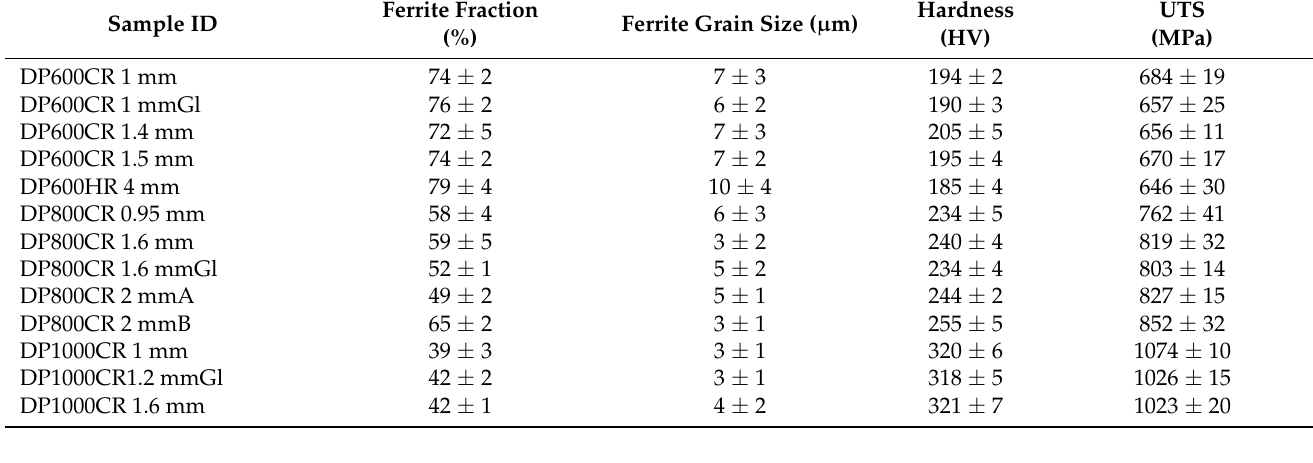
Figure 1. SEM micrograph of commercial DP600, DP800 and DP1000 steel samples (in InLens mode with 5 kV). Table 1. Summary of the ferrite fraction, hardness and grain size of commercial DP steels, HR = Hot-rolled, CR = Cold-rolled, Gl = Galvanised, mm = sample thickness.